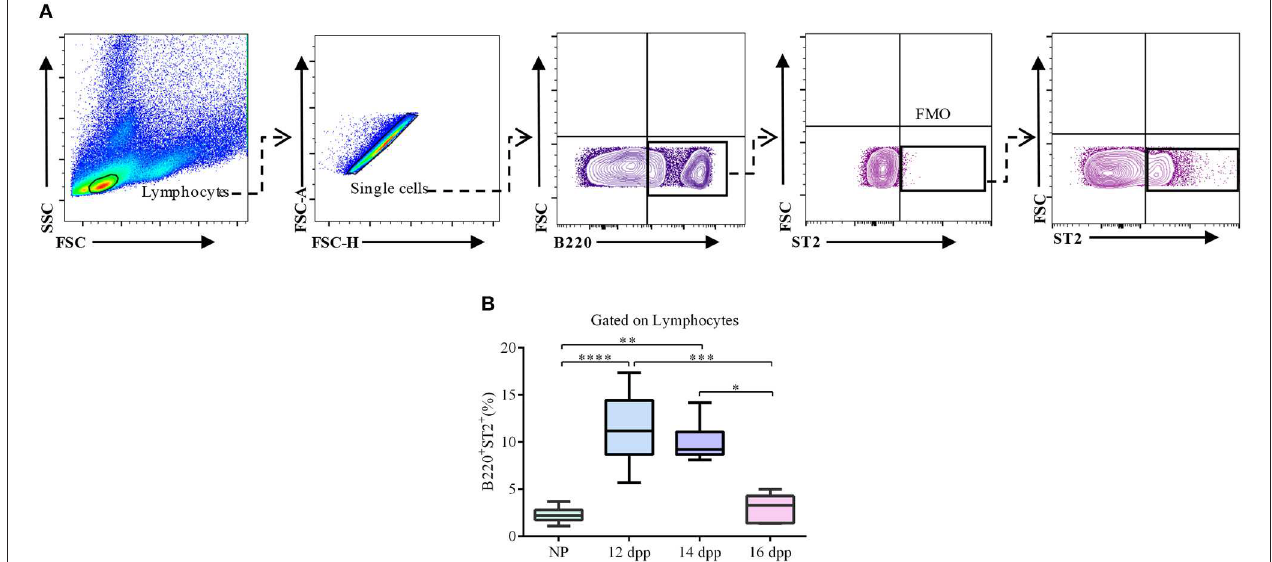
FIGURE 2 | Kinetic analysis of ST2 expression in splenic B cells throughout pregnancy. (A) Representative pseudocolor and contour plots showing gating strategy used to quantify percentages of ST2-expressing B cells in the spleen of pregnant and non-pregnant females. Lymphocytes were gated by FSC vs. SCC, doublets were eliminated, and B220 was used to define total B cell population in the spleen. Fluorescence minus one (FMO) was used as control. (B) Box and whisker plots showing percentages of ST2-expressing total B cells in the spleen of pregnant mice on day 12 (12 dpp; n = 9), 14 (14 dpp; n = 11), and 16 (16 dpp; n = 7) of pregnancy as well as in non-pregnant control females (NP, n = 11). Data are expressed as Box and Whisker plots showing median. * p < 0.05; ** p < 0.01; *** p < 0. 001; and **** p < 0.0001 as analyzed by Kruskal–Wallis test followed by Dunn’s multiple comparisons